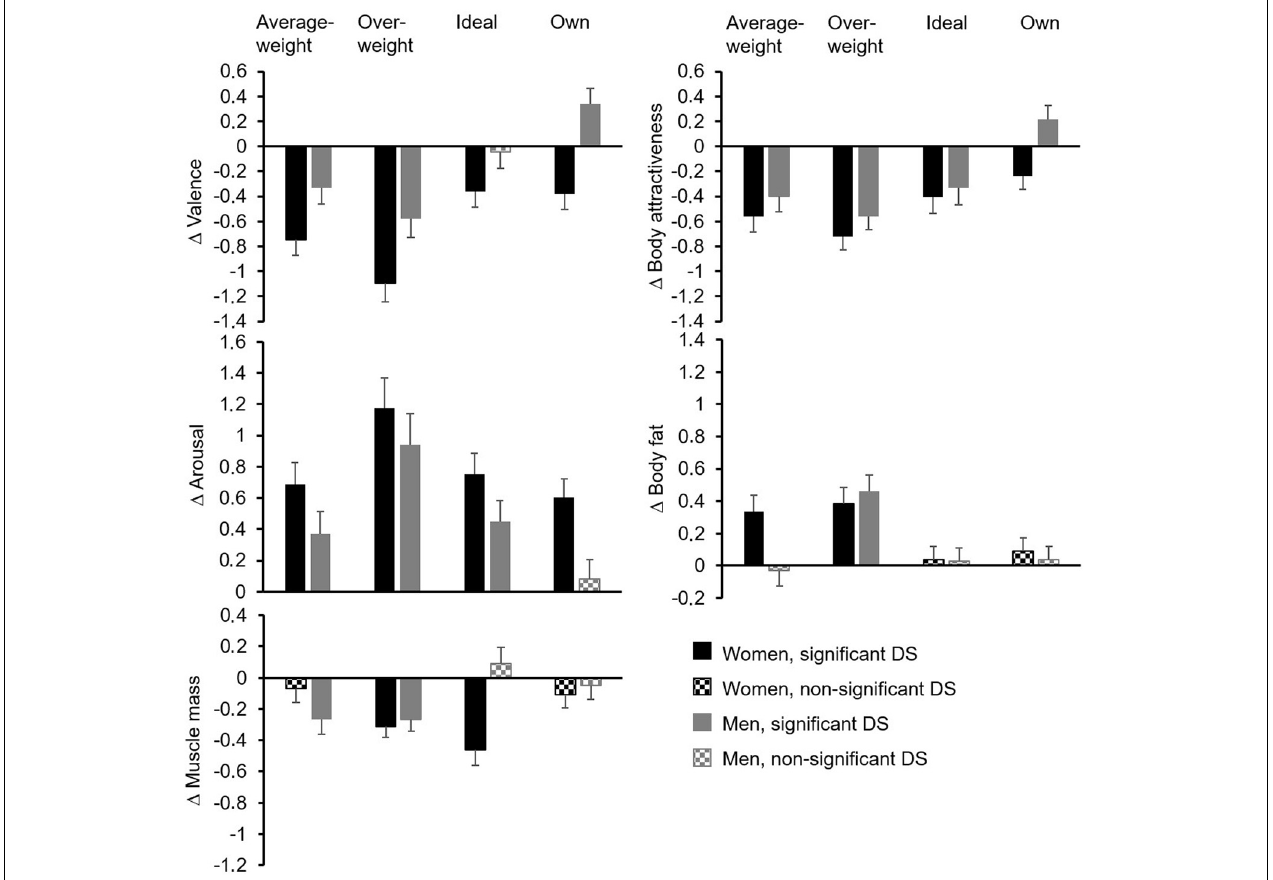
FIGURE 2 | The means and standard errors of the double standards (DS) dependent on Group and Build.